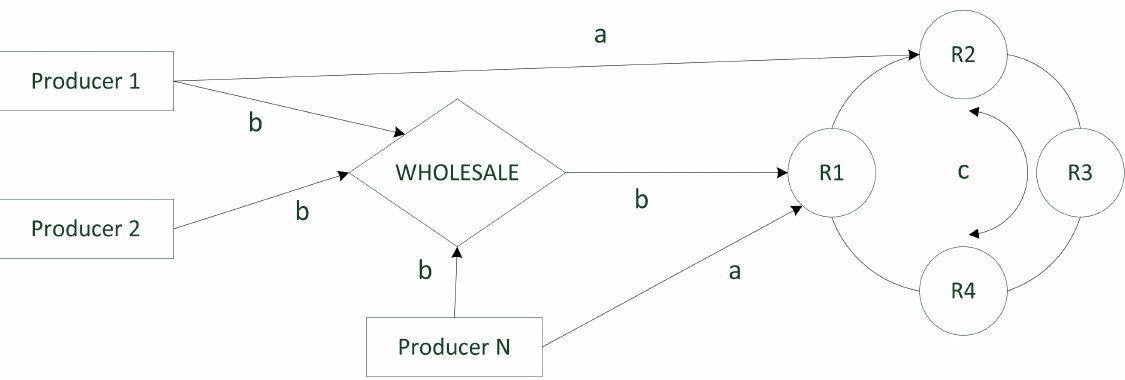
Figure 2. Different modes of transport from producer to retailers (R—retailer, a—direct route, b— chain route, c—circle